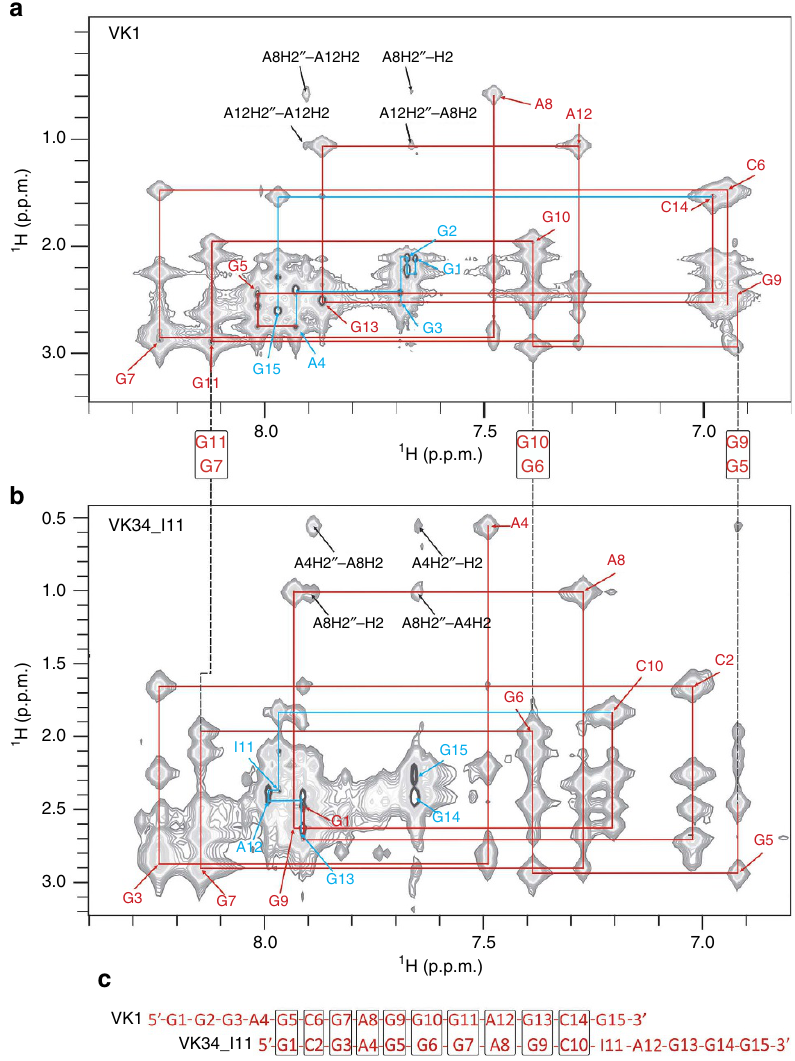
Figure 7 | VK1 and VK34 folds have a very similar NOE fingerprint. Comparison of H2 0 /H2 00 -aromatic regions of NOESY spectra of ( a ) VK1 and ( b ) VK34_I11. Cross-peaks with very similar NOE fingerprints in NOESYspectra of VK1 and VK34_I11 are indicated in red. NOE fingerprints without similarities are indicated in blue. ( c ) Sequences of VK1 and VK34_I11 oligonucleotides. Residues with similar NOE fingerprints are indicated by black frames. NOESY spectra (mixing time of 200ms) of VK1 and VK34_11 folds were recorded at 1.0mM oligonucleotide concentrations per strand and 100mM LiCl, 0 (cid:2) C and pH